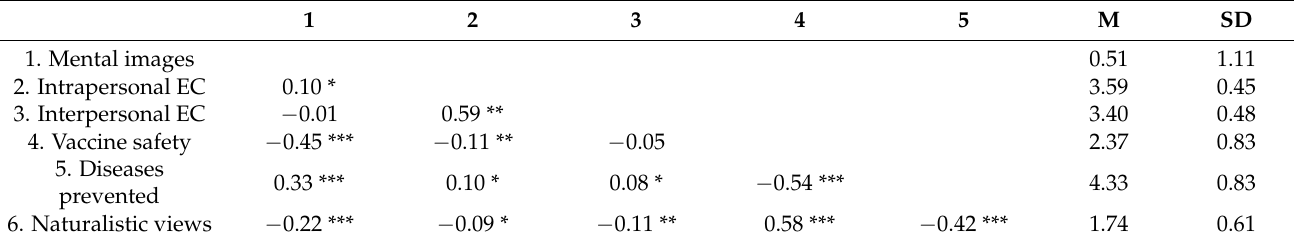
Table 4. Descriptive statistics and correlations (Study